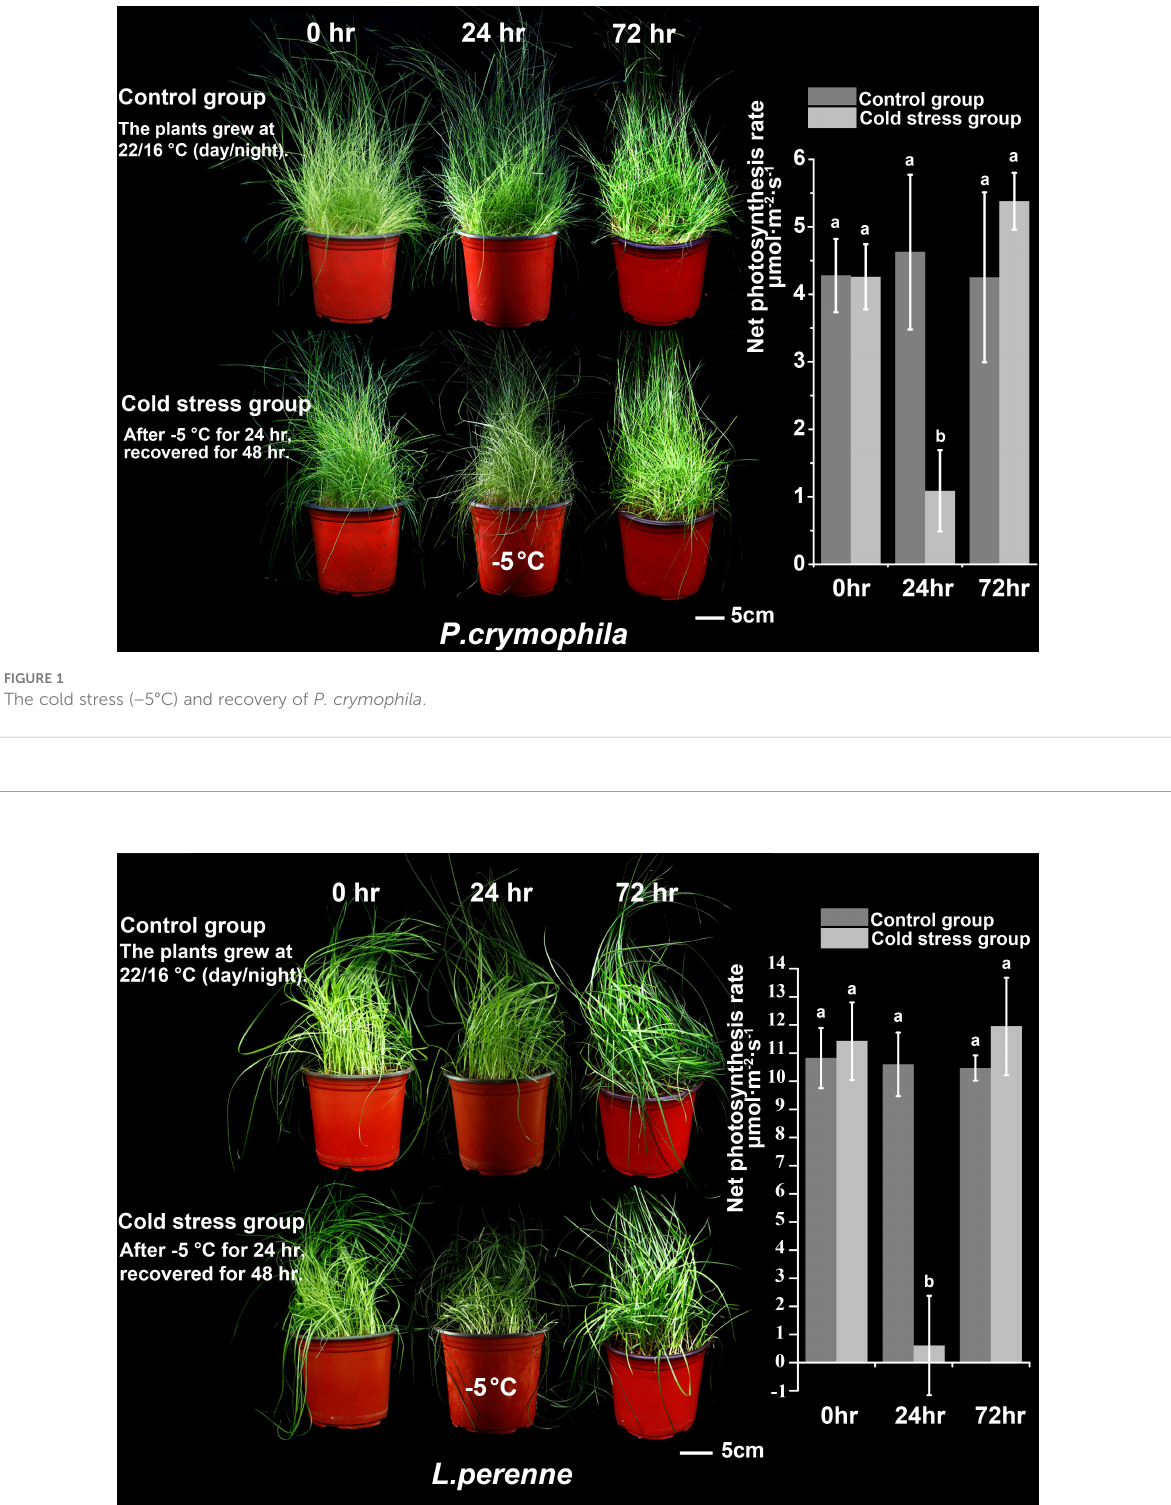
FIGURE 2 The cold stress ( − 5°C) and recovery of L. perenne .